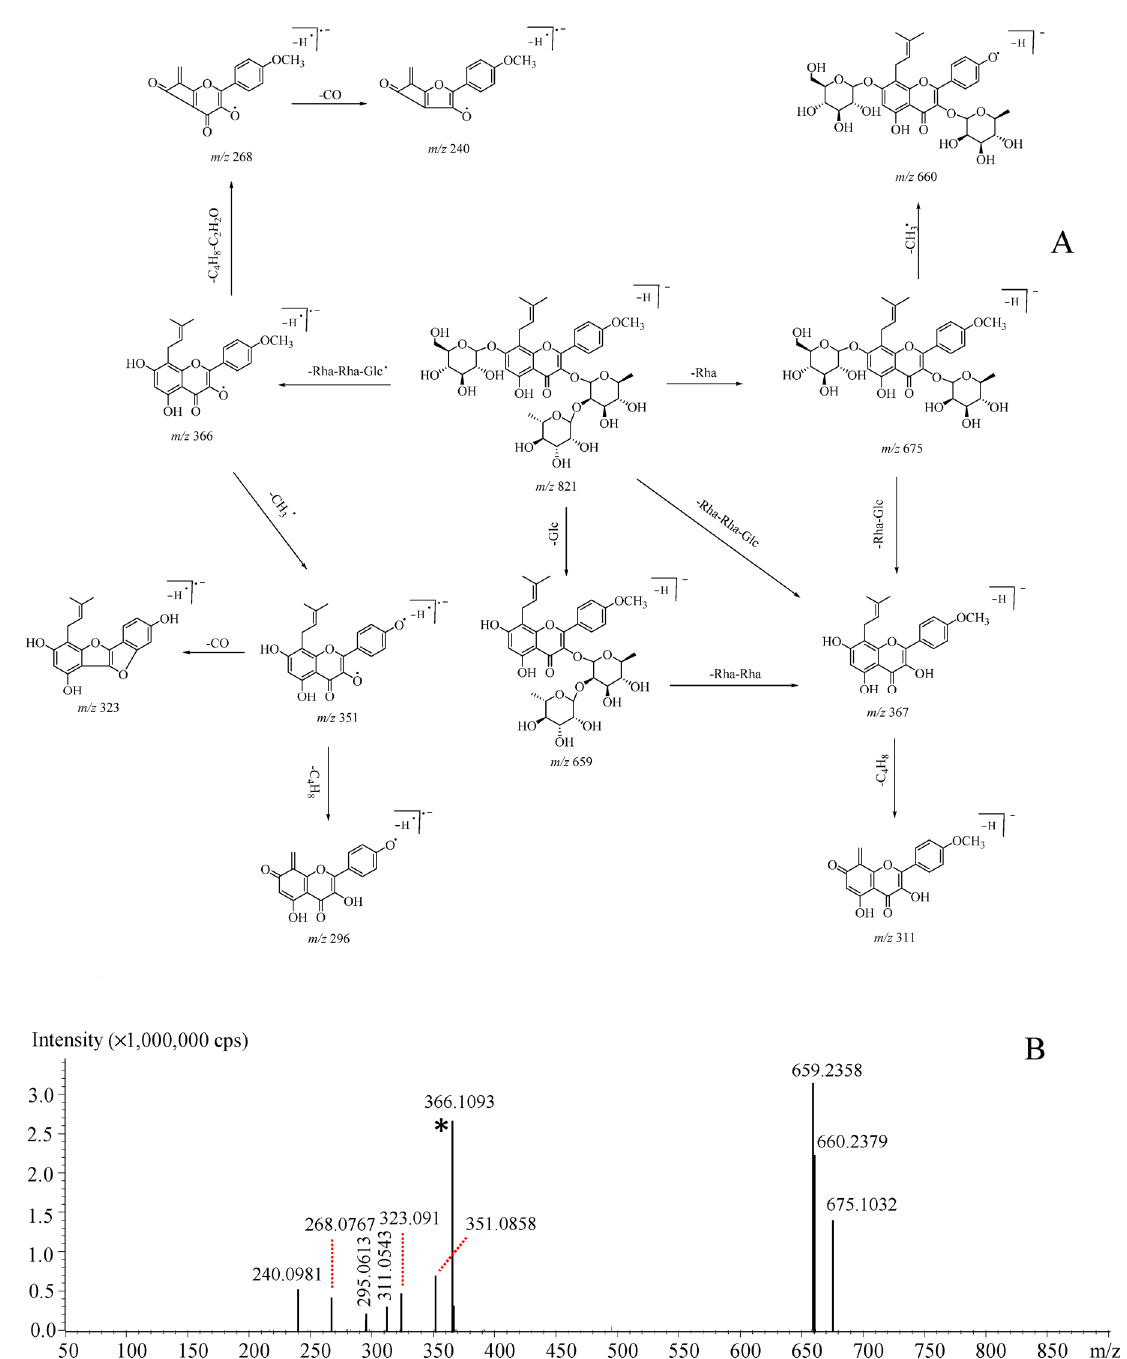
Figure 3. Proposed mass fragmentation pathways ( A ) and MS 2 spectrum ( B ) of m / z 821 ([M–H] − ) for epimedin C, a representative isopentenyl flavonoid in Epimedium plants. * : [Y 0 –H · ] −